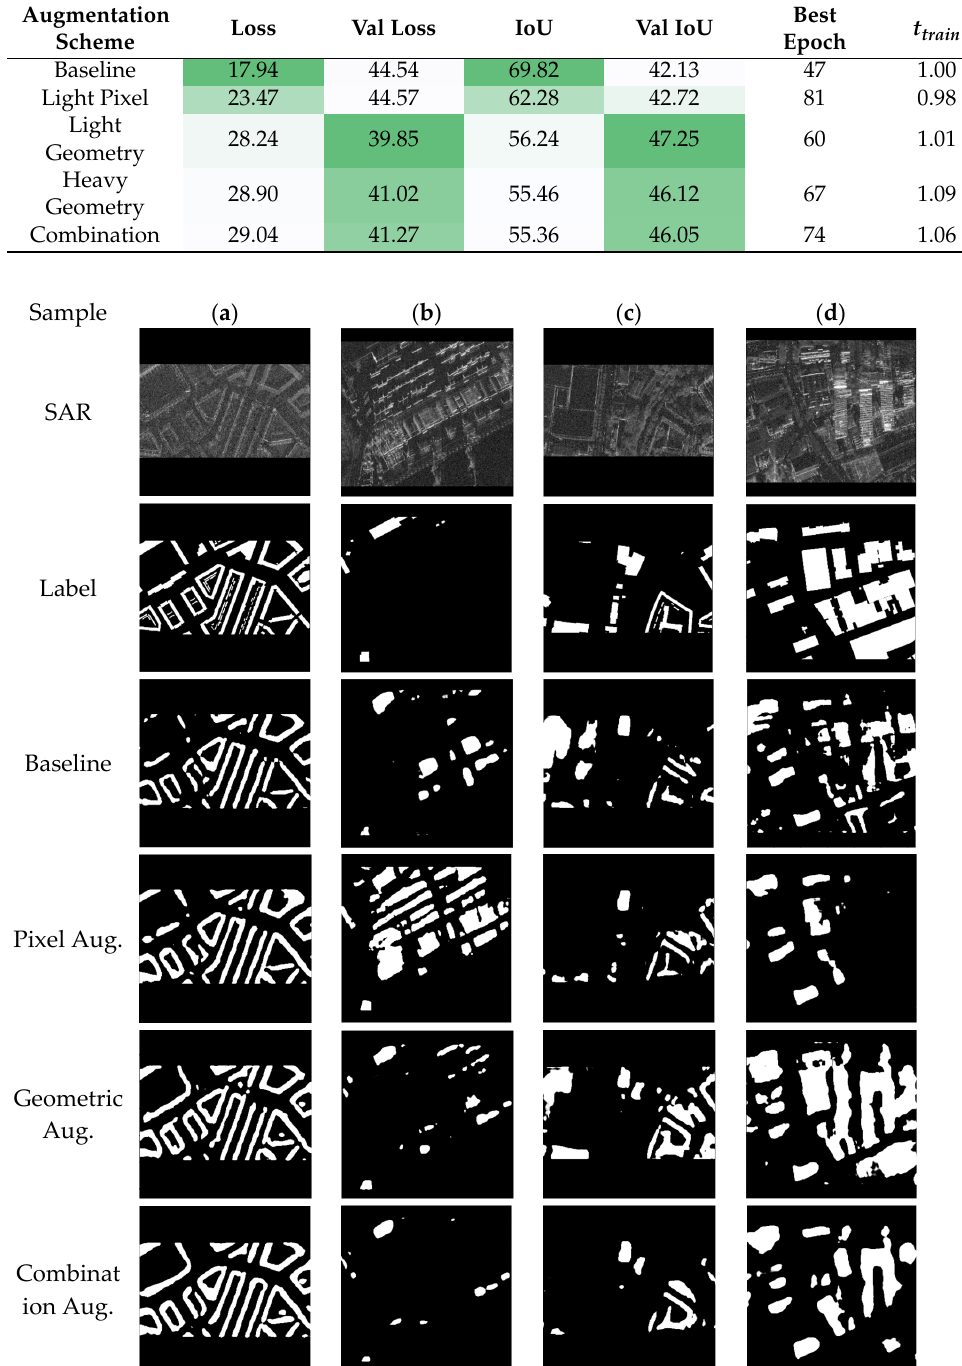
Table 3. Results of combining multiple augmentations. All loss and IoU scores are in percentage. t train is the scale of training time compared to the Baseline. A lower value indicates faster training time. For loss, lower is better. For IoU, higher is better. Scores are color-coded where a darker green indicates a better value.